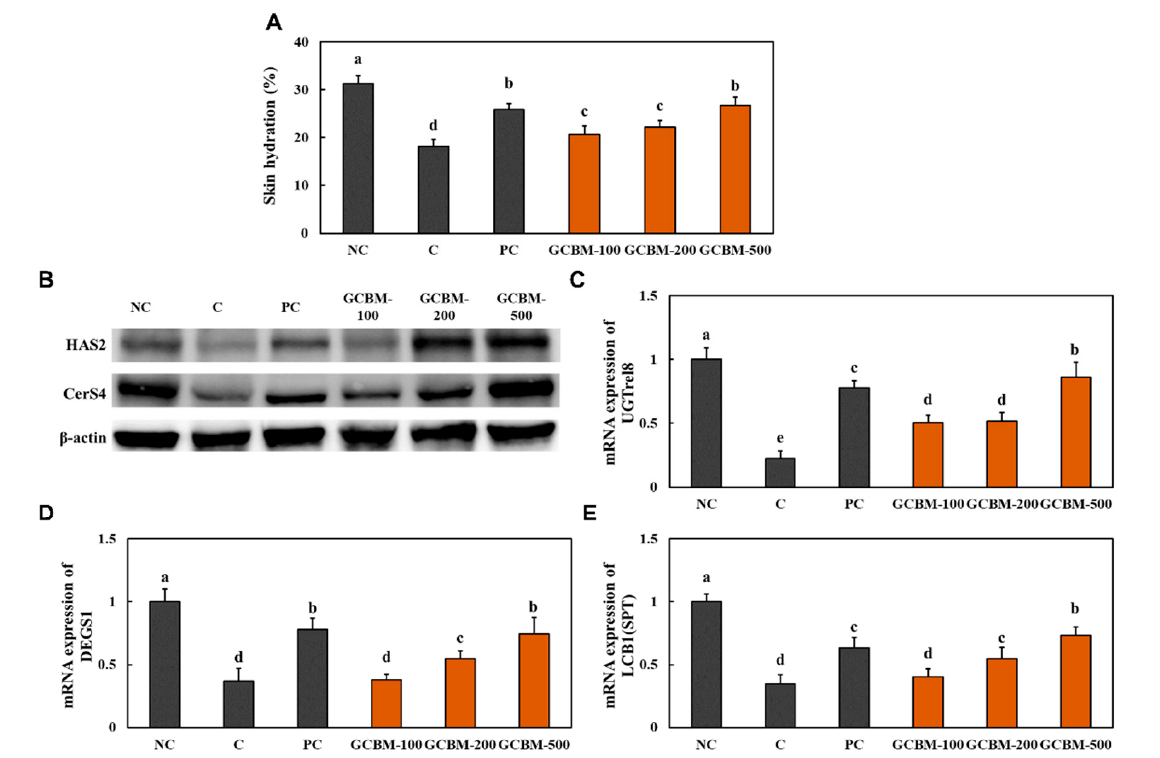
Figure 5. Effects of GCBM on skin hydration ( A ), protein expression of HAS2 and CerS4 ( B ), and mRNA expression of UGTrel8 ( C ), DEGS1 ( D ), and LCB1 ( E ) in the dorsal skin of UVB irradiation- induced photoaging in mice. Normal control (NC), control (C; UVB-irradiation), positive control (PC; UVB-irradiation with diet containing L -ascorbic acid at 100 mg/kg/body weight [b.w.]), GCBM-100 (UVB-irradiation with dietary supplementation of GCBM at 100 mg/kg/b.w.), GCBM-200 (UVB-irradiation with dietary supplementation of GCBM at 200 mg/kg/b.w.), and GCBM-500 (UVB-irradiation with dietary supplementation of GCBM at 500 mg/kg/b.w.). Values are presented as mean ± SD. Different letters (a > b > c > d > e) indicate a significant difference, with p < 0.05, as determined with Duncan’s multiple range